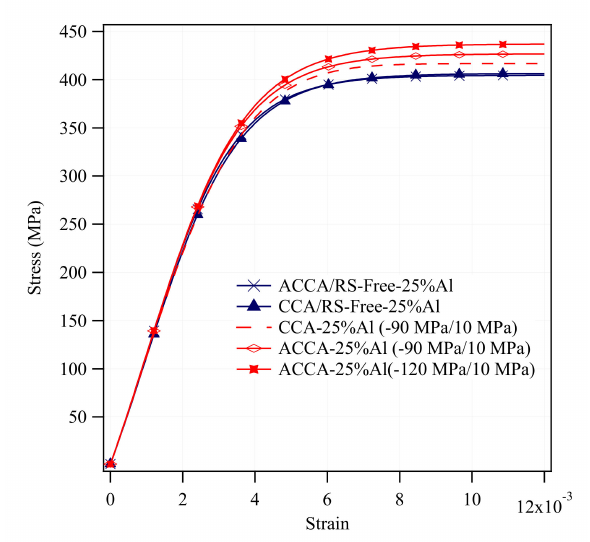
Figure 11. Numerical stress-strain curves of ≈ 25%Al-ACCA and 25%Al-CCA wires (with and without residual stress